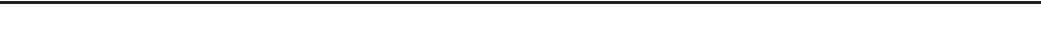
Fig. 8. Fruits of Icacinaceae Miers. 1 – 9 . Cassinopsis madagascariensis Baill. ( P.P. Lowry et al. 5162 ). 1 . Broken fruit, lateral view. 2 – 6 . Broken endocarp. 2 . Lateral view showing a reticulate pattern of ridges. 3 . Dorsal view showing a keel surrounding the endocarp. 4 . Opposite lateral view. 5 . Apical view. 6 . Basal view. 7 . SEM image of the pericarp in transverse section. 8 . Detail of the same section